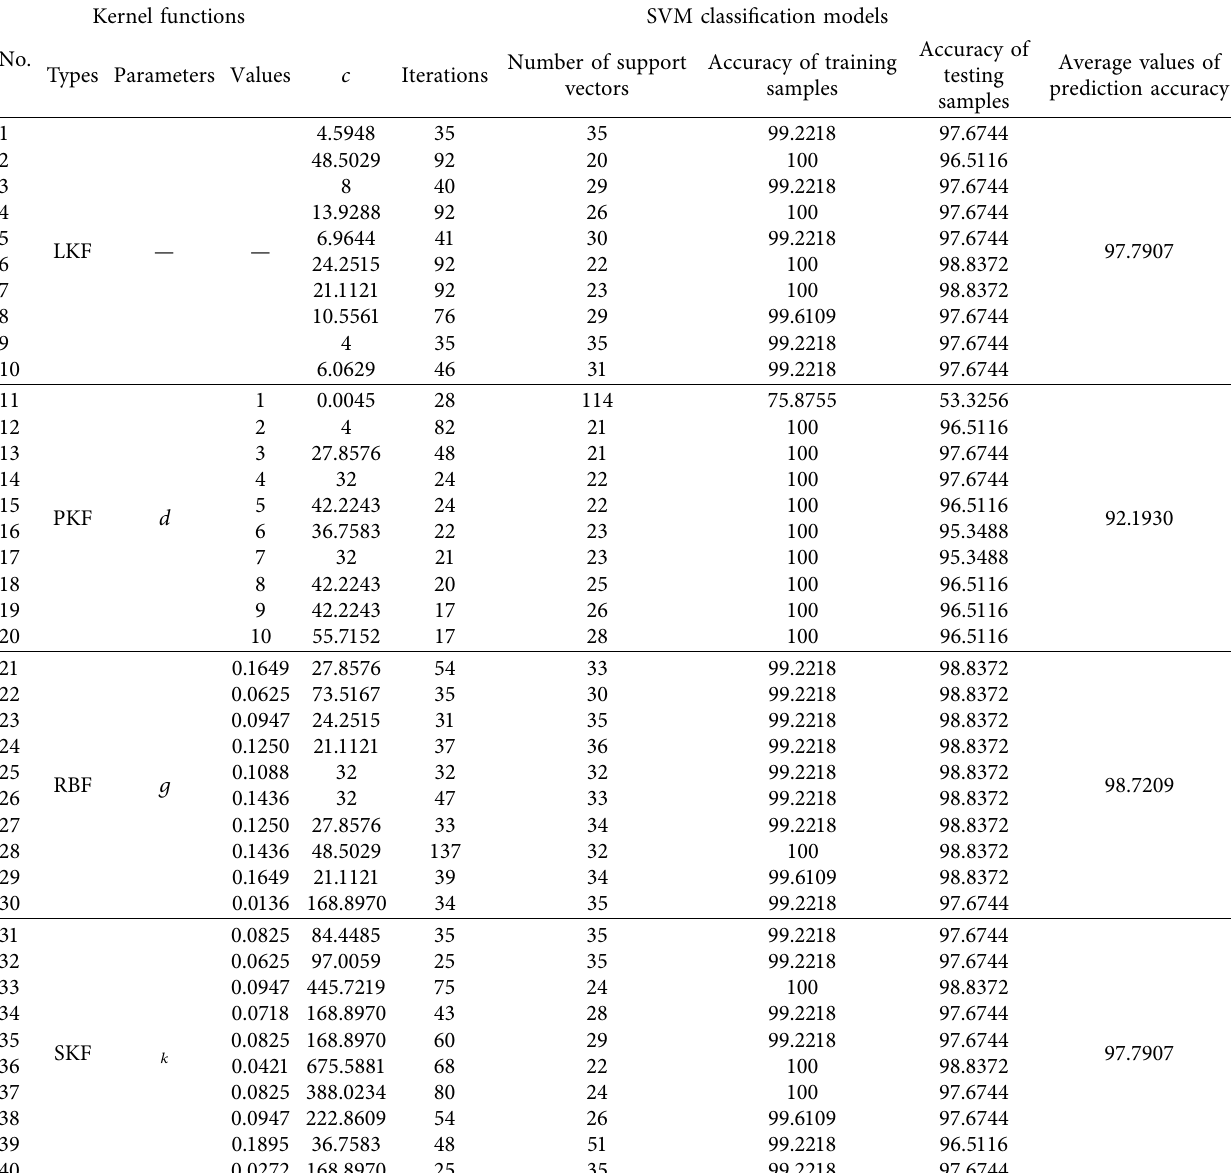
Table 11: Parameters and prediction accuracy of SVM classification models with different kernel